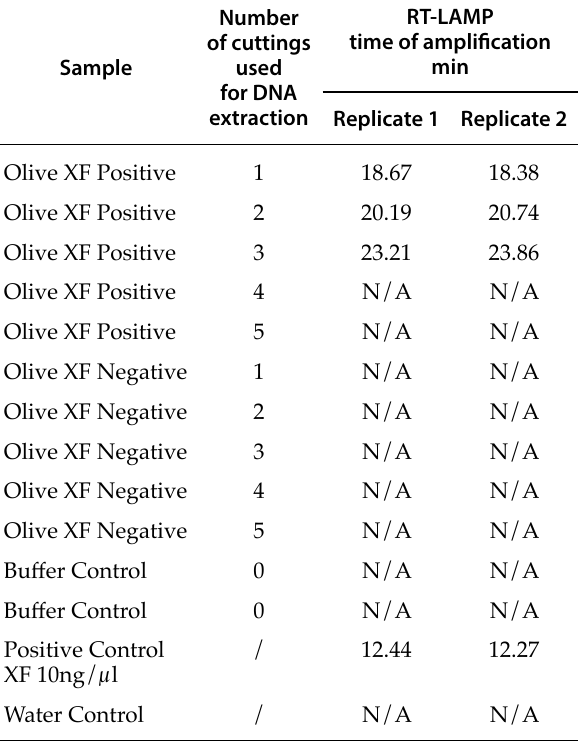
Table 3. Detection of X. fastidiosa from olive plants by real- time LAMP. Infected tissues for DNA extraction were thin slices of one-year-old olive twigs, 1-2 mm of thickness, from a number of slices ranging from 1 to 5 for each ex-